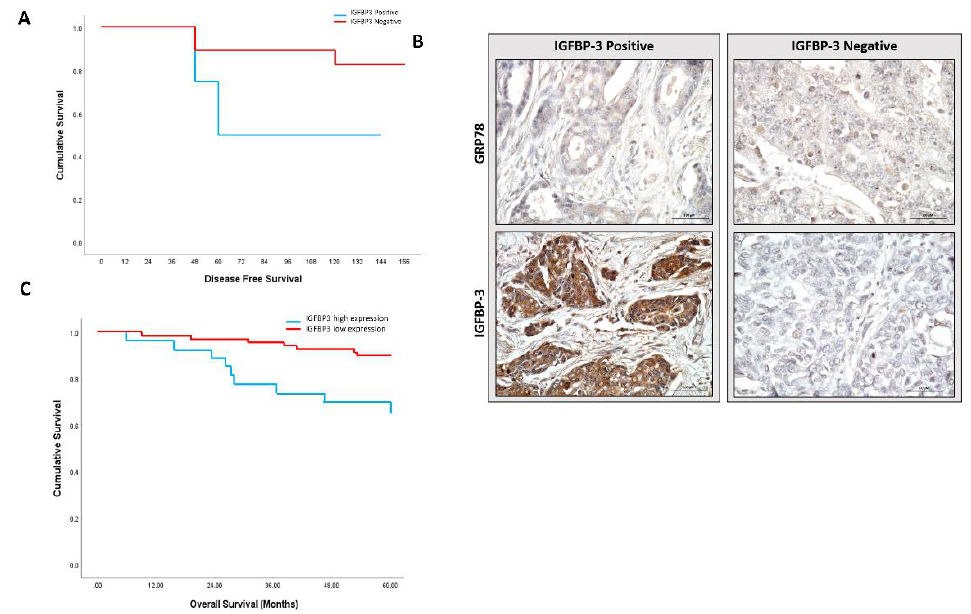
Figure 4. Loss of GRP78 is associated with worse clinical outcome. ( A ) Kaplan–Meier plots of disease-free survival for low and high staining of IGFBP-3 in GRP78-negative tumours ( n = 26; p = 0.134). ( B ) Representative images of GRP78 and IGFBP-3 IHC staining. ( C ) The overall survival of breast cancer patients was analysed in the METABRIC database in GRP78-negative tumours based on IGFBP-3 gene expression profile ( n = 83; p = 0.003). Statistically significant differences were determined by two-sided log-rank test.